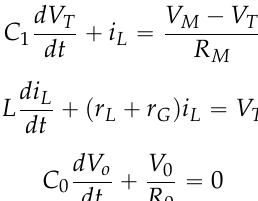
Figure 7. Circuit diagram in switch ON/OFF.